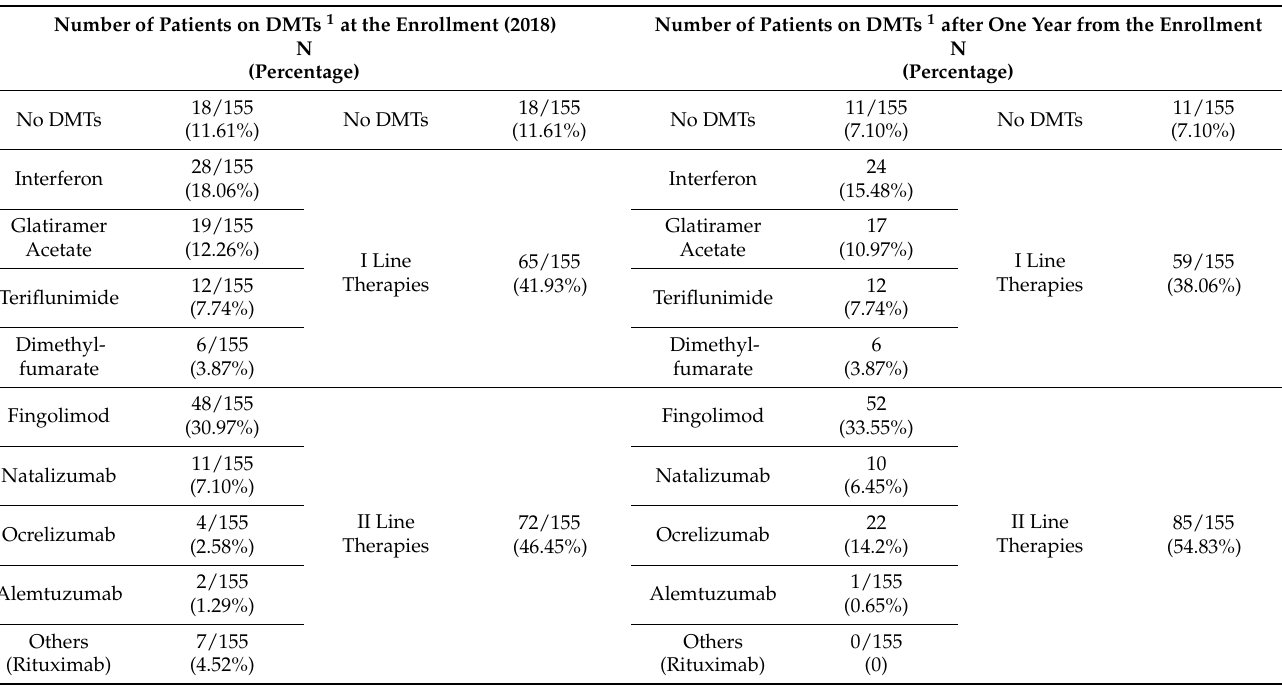
Table 2. Patient distribution according to ongoing DMTs at study enrollment and after one year.